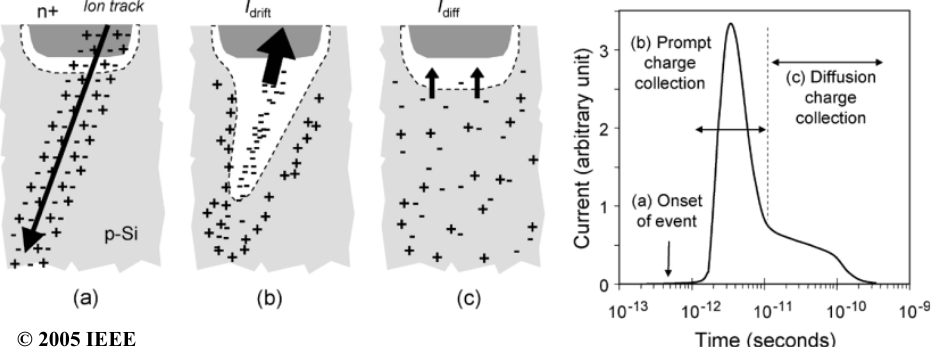
Figure 2. Illustration of radiation induced processes in a reverse-biased n+/p diode and the resulting current transient caused by the radiation strike: ( a ) Onset of radiation strike, ( b ) prompt charge collection, and ( c ) charge collection through diffusion. Figure is reproduced from [33] with permission of